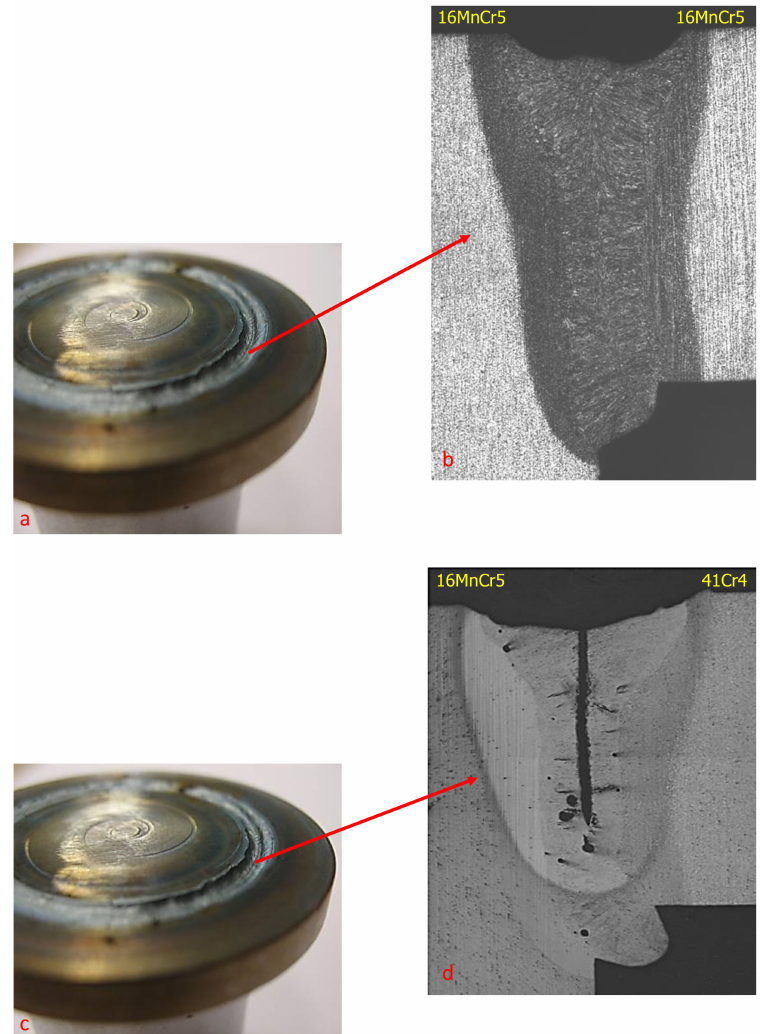
Figure 10. Effect of material type and component geometry on the quality of the weld. ( a – b ) Picture of the weld top profile and micrograph of the weld cross section for the 16MnCr5-16MnCr5 material combination; ( c – d ) picture of the weld top profile and micrograph of the weld cross section for the 16MnCr5-41Cr4 material